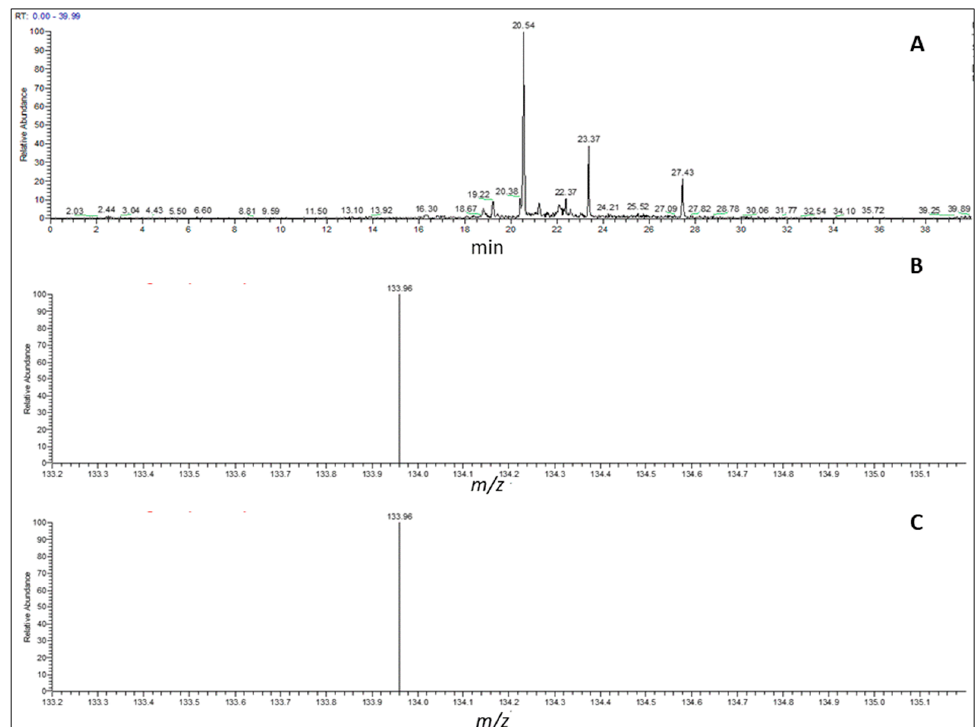
Figure 1. The chromatogram of an ion product with m/z 193 obtained from the HUPLC-MS/MS analysis of digested BSG extract ( A ). Chromatogram recorded at 320 nm; ( B ). Mass spectrum of parent ion with m/z 193; ( C ). Mass spectrum of fragmentation of parent ion with m/z 193 . LOQ and LOD values determined for ferulic acid were 0.062 and 0.016 µg/mL, respectively.